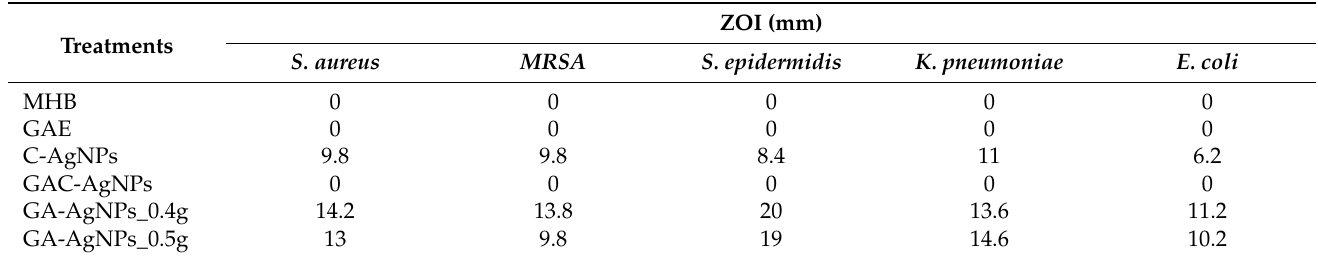
Table 3. Anti-bacterial activity of the synthesized AgNPs.